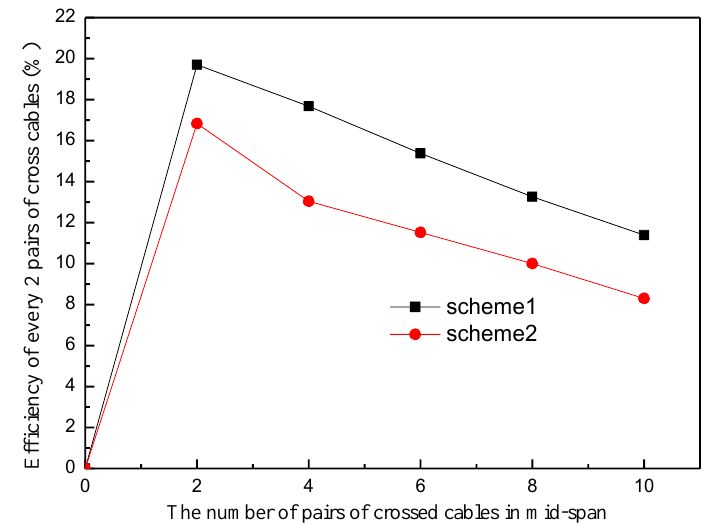
Figure 9. Efficiency of every 2 pairs of cross cables.